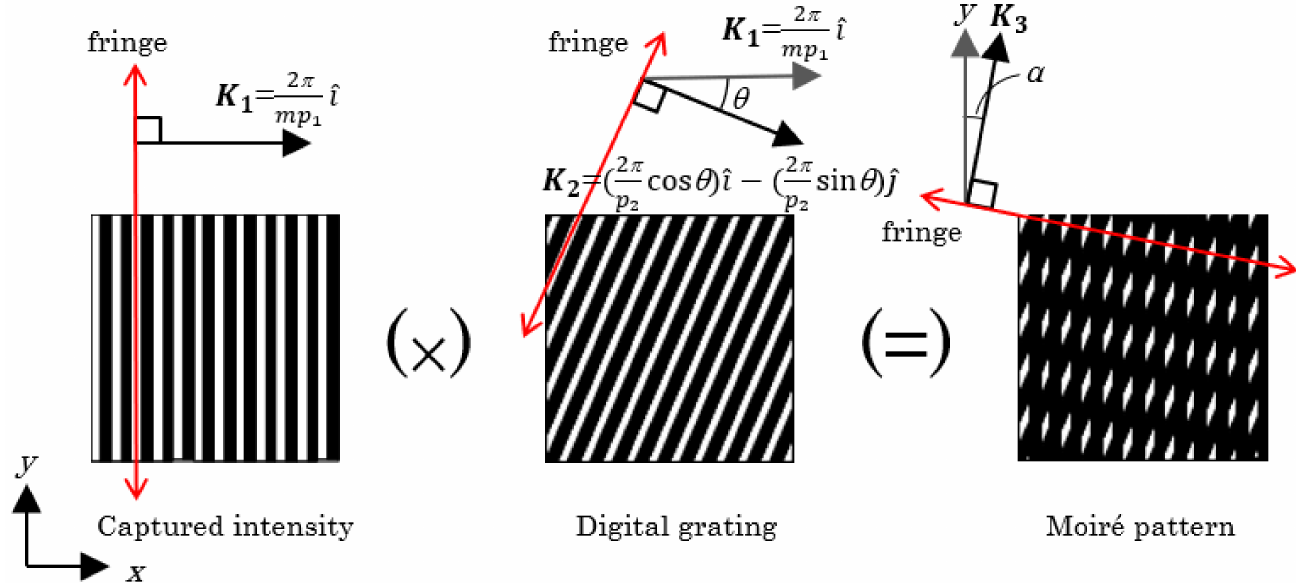
Figure 2. Schematic illustration for the generation of moir é pattern and related